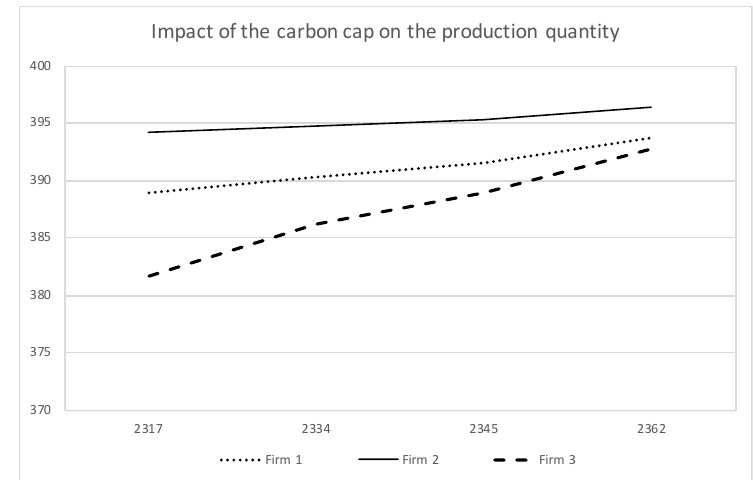
Figure 2. Impact of the carbon cap on the production quantity (unit).